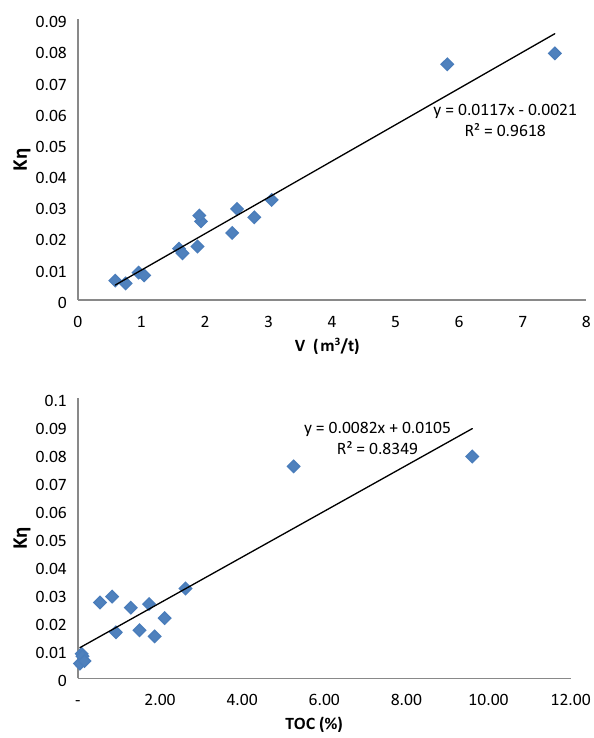
Fig. 6 Diagram of the relationship between shale resolution effi- ciency and isotherm adsorption gas content &